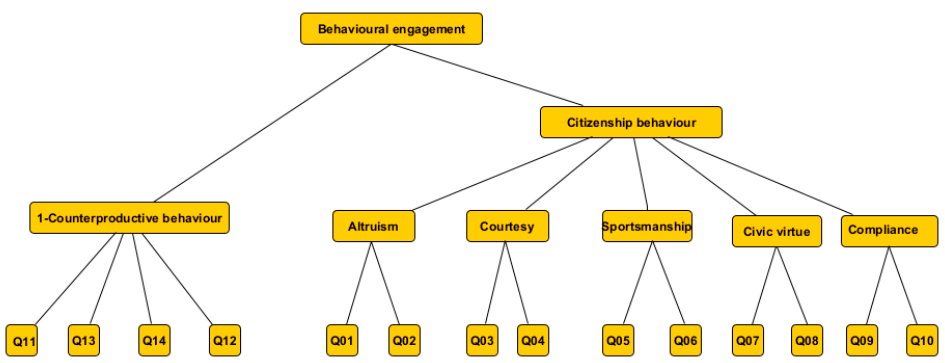
Figure 4. Fuzzy signature structure according to [9].